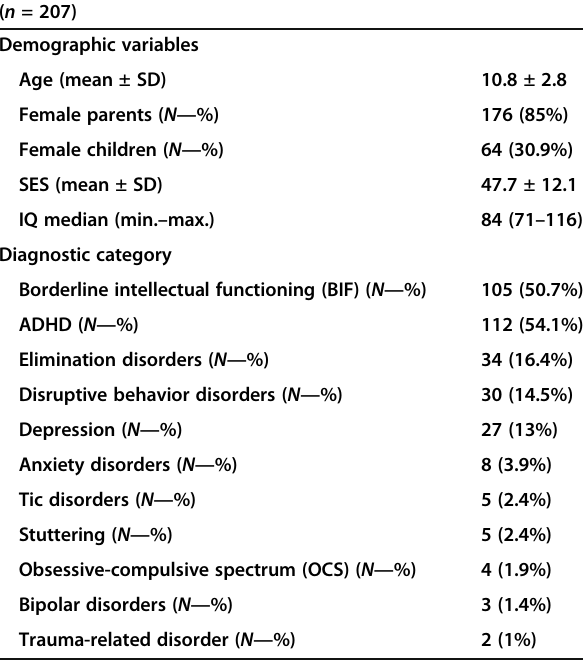
Table 1 Demographic and clinical characteristics of the